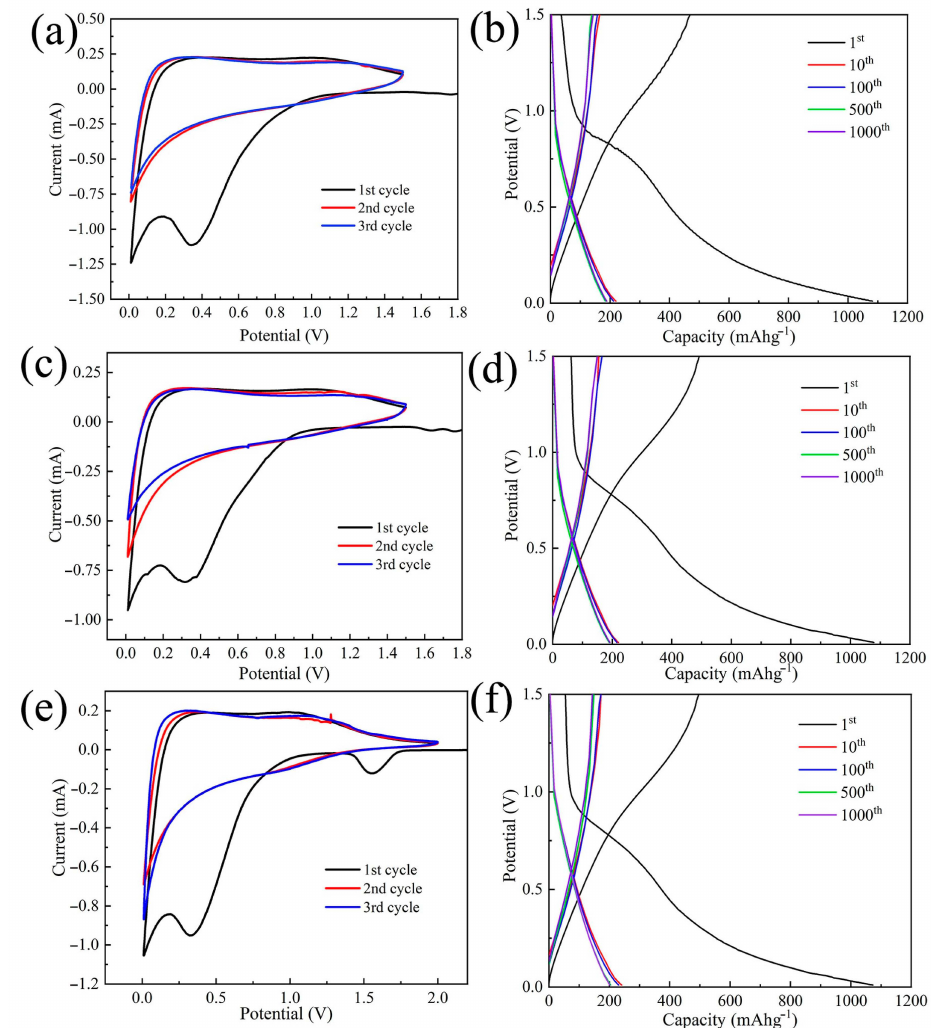
Figure 9. CV curves of ( a ) CNMs, ( c ) CNMs − PC ( e ) CNMs − CC at 0.1 mVs − 1 and discharge/charge profiles for ( b ) CNMs, ( d ) CNMs − PC and ( f ) CNMs − CC at a current density of 1A g − 1